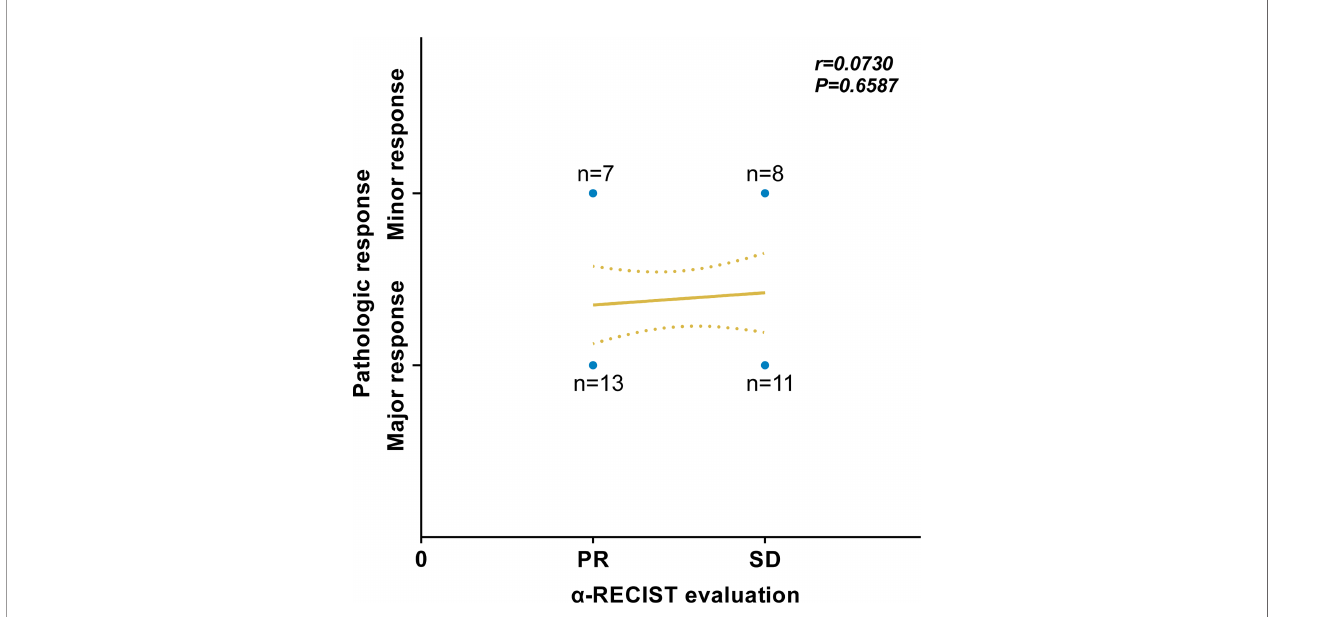
FIGURE 6 | Correlation between a -RECIST evaluation and pathologic response evaluation.